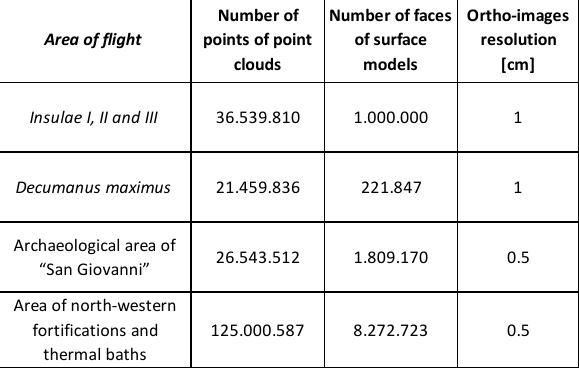
Table 2. Results of photogrammetric processes for each archaeological